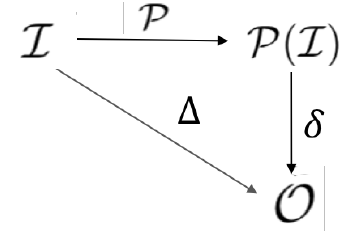
Figure 5. Commutative